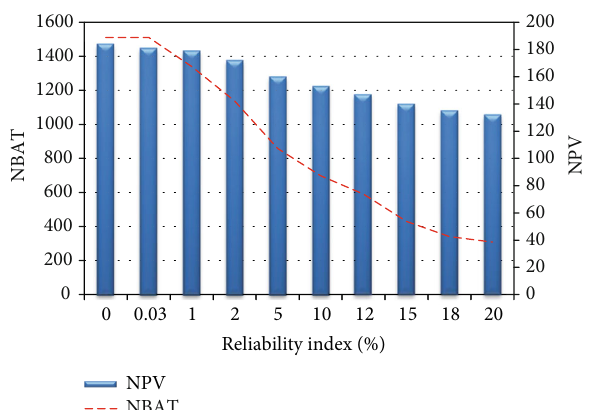
Figure 8: Cost index of optimal components vs. reliability indexes in the optimal